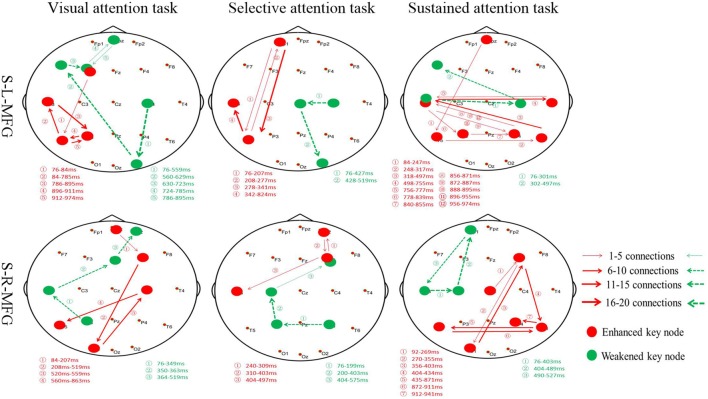
Key nodes were altered during different attention modes. Red digits: conversion time of enhanced key nodes. Green digits: conversion time of weakened key nodes. Red lines and arrows: the direction of enhanced key nodes information flow. Green lines and arrows: the direction of weakened key nodes information flow. S, single TMS, L, left hemisphere, R, right hemisphere, MFG, middle frontal gyrus.